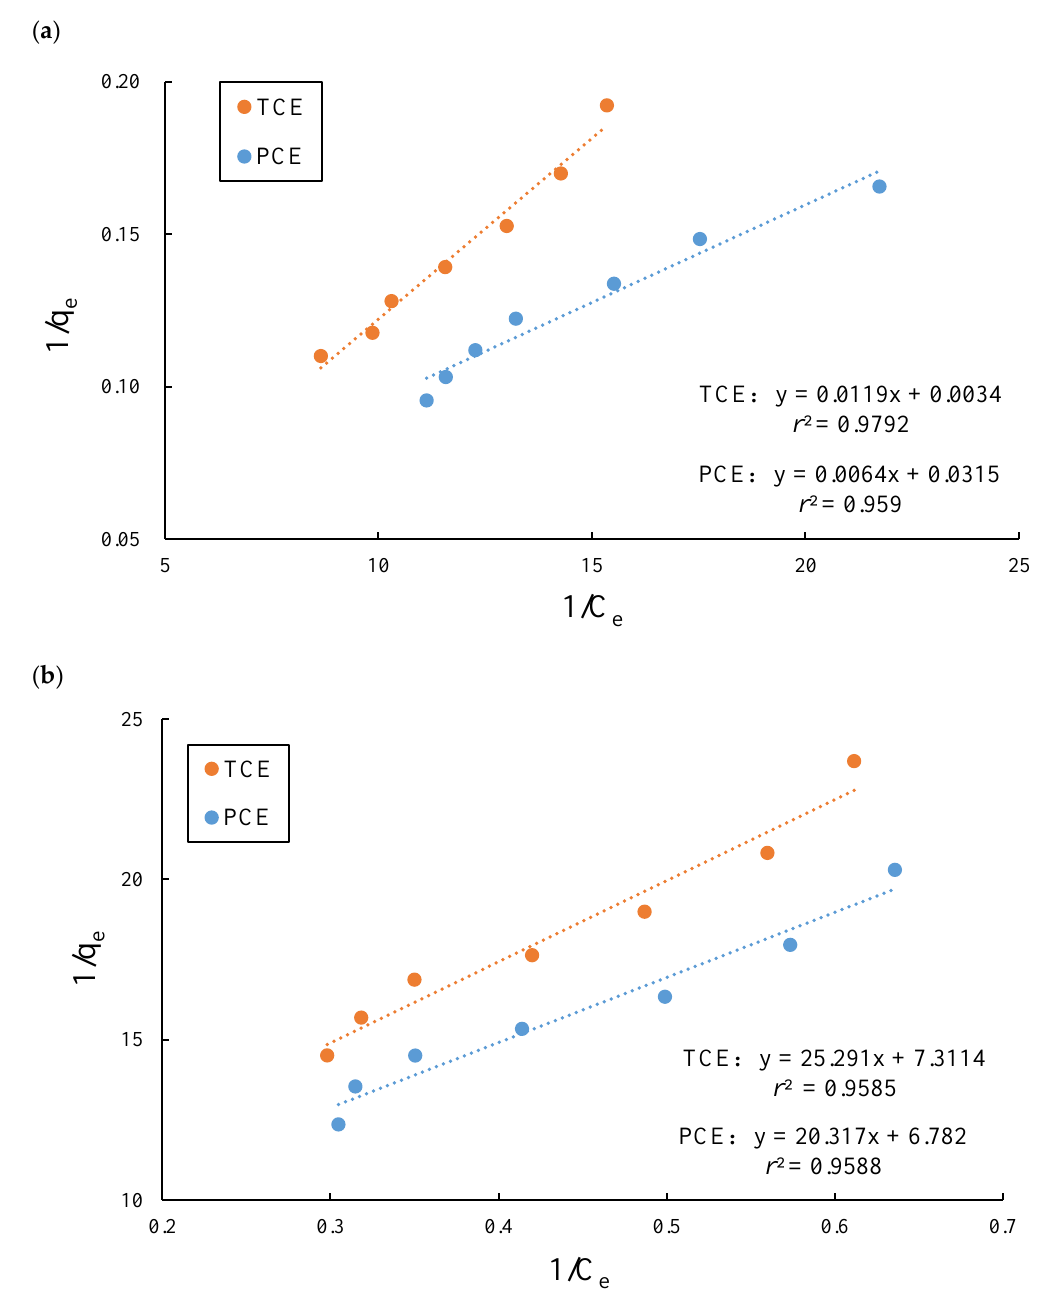
Figure 6. Experimental data of ( a ) activated carbon and ( b ) silica gel adsorption onto TCE and PCE fitted to linearized forms of Langmuir isotherms. Table 9. Adsorption parameters of Freundlich and Langmuir isotherm